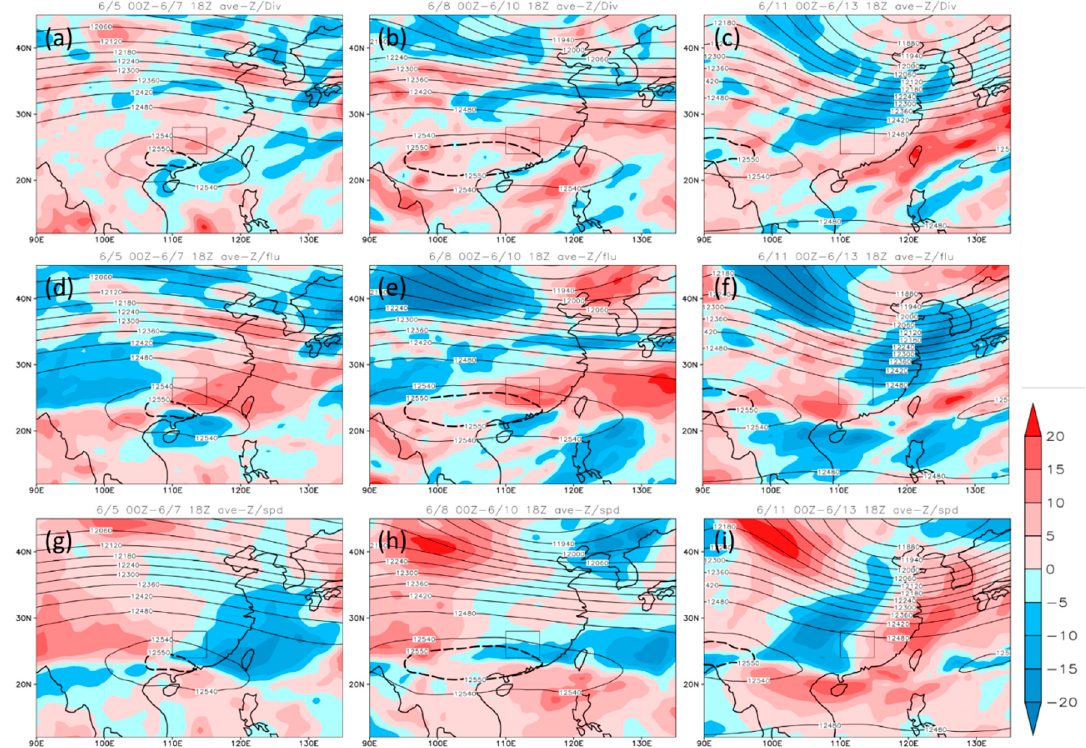
Figure 15. Time-averaged geopotential height (gpm, contours, every 60 gpm, additional dashed contours where needed) and divergence ( D , color, 10 − 6 s − 1 ) from the ERA-Interim data at 200 hPa over ( a ) 0000 UTC 5 to 1800 UTC 7, ( b ) 0000 UTC 8 to 1800 UTC 10, and ( c ) 0000 UTC 11 to 1800 UTC 13 June 2012, respectively. ( d – f ) As in ( a – c ) but for diffluence component of D . ( g – i ) As in ( a – c ) but for the speed divergence/convergence of D . The box for average in South China is also plotted.